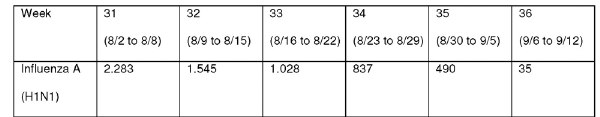
Figure 1 - Distribution of cases of acute respiratory syndrome in Brazil according to epidemiologic week from week 31 to 36, 2009 (data obtained from Ministry of Health of Brazil) 9